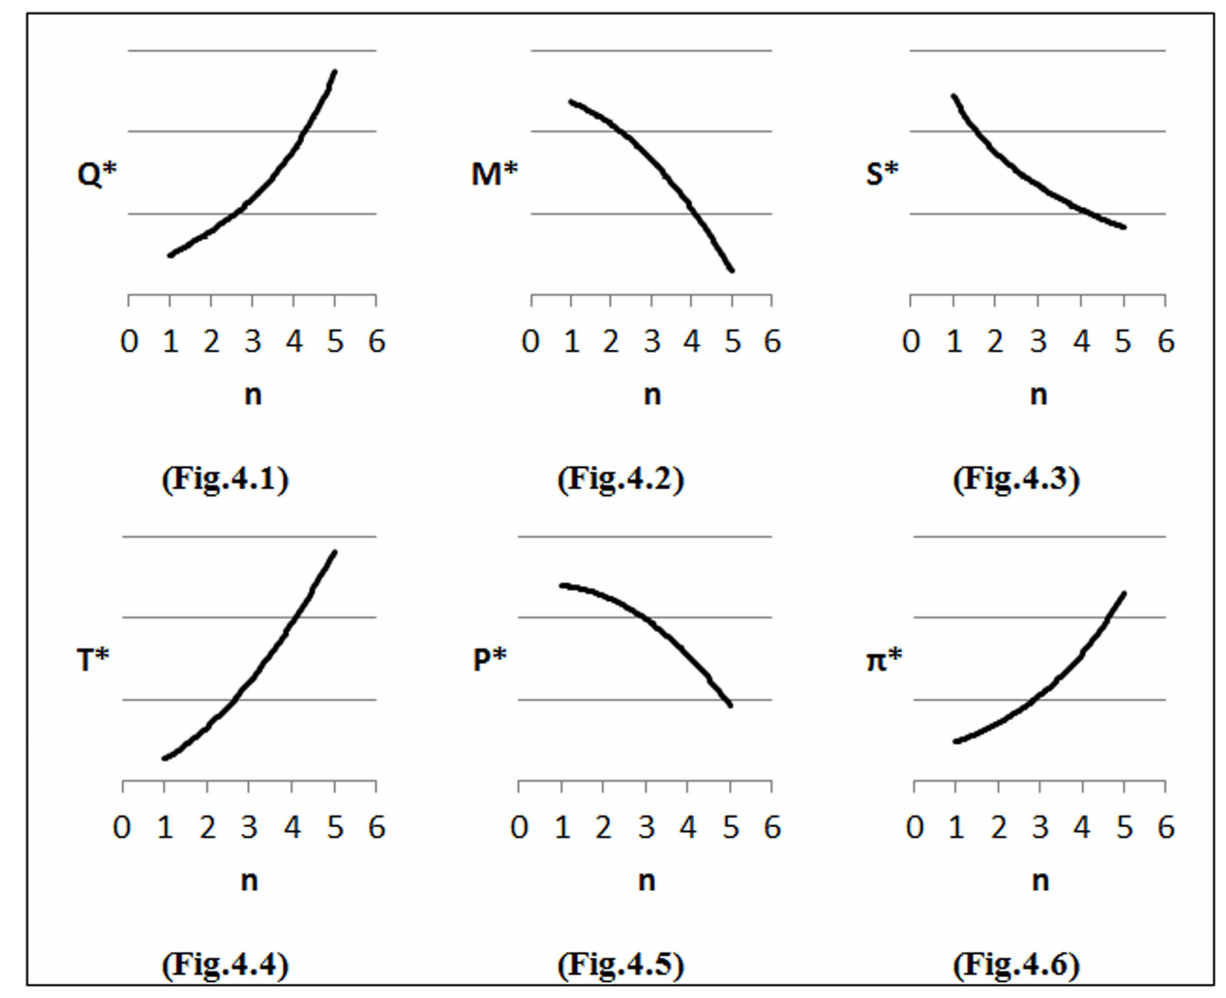
Fig 4. Effects of changes in ( k ) on decision